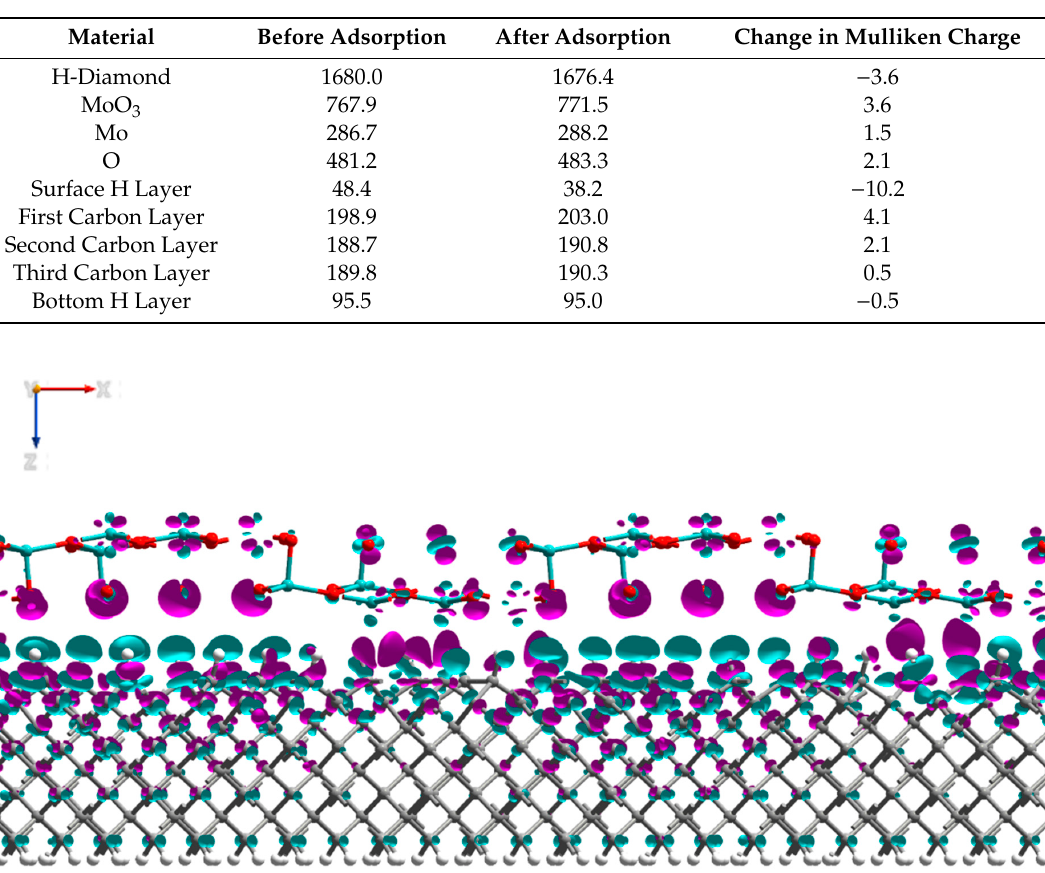
Table 2. The calculated Mulliken charges for the MoO3-doped diamond surface.